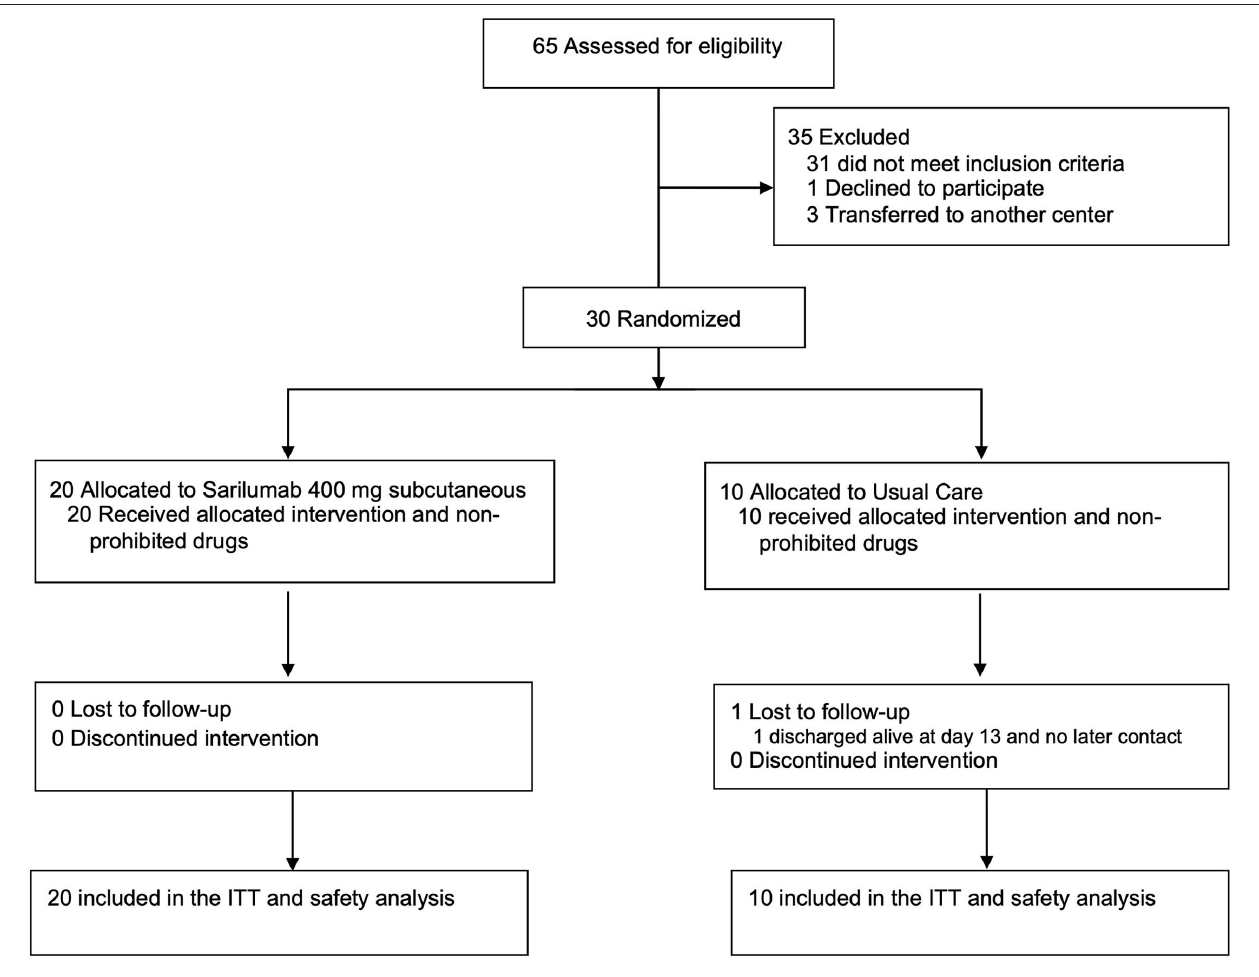
FIGURE 1 | Flow chart of the